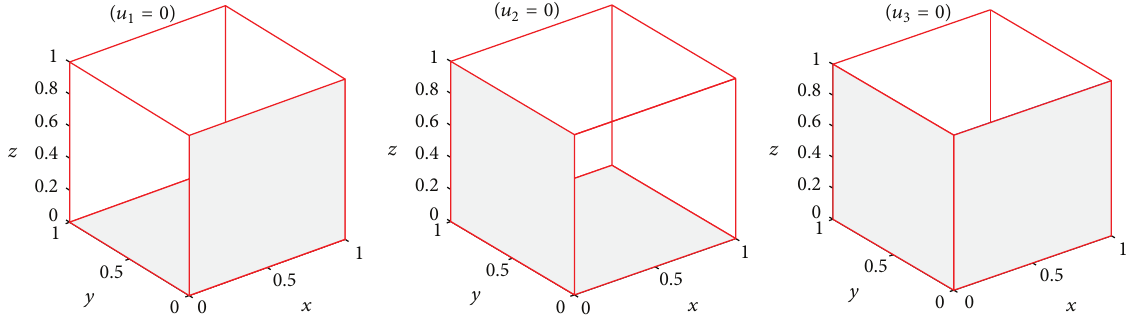
Figure 3: Slip boundary condition (curl).